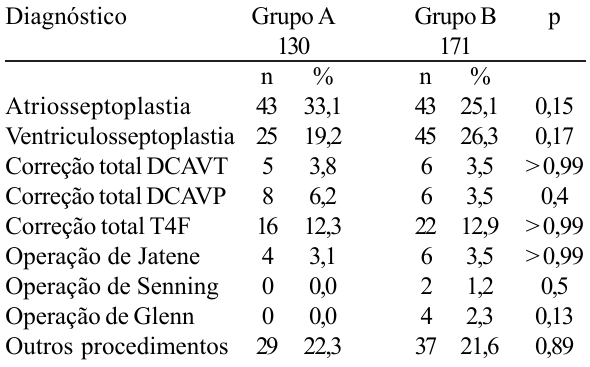
DCAVT - defeito do canal atrioventricular forma total, DCAVP - defeito do canal atrioventricular forma total, T4F - tetralogia de